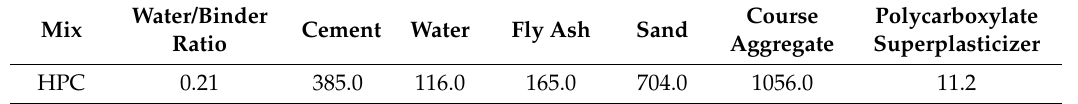
Table 1. Proportions (kg/m 3 ).